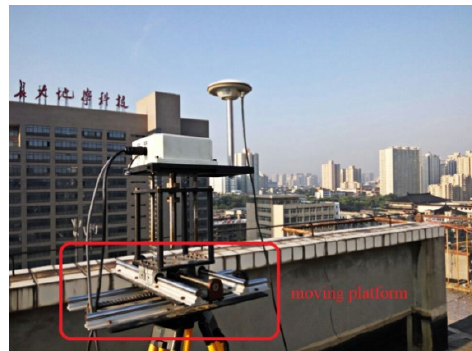
Figure 3. Distribution of stations CD01 and CD02.